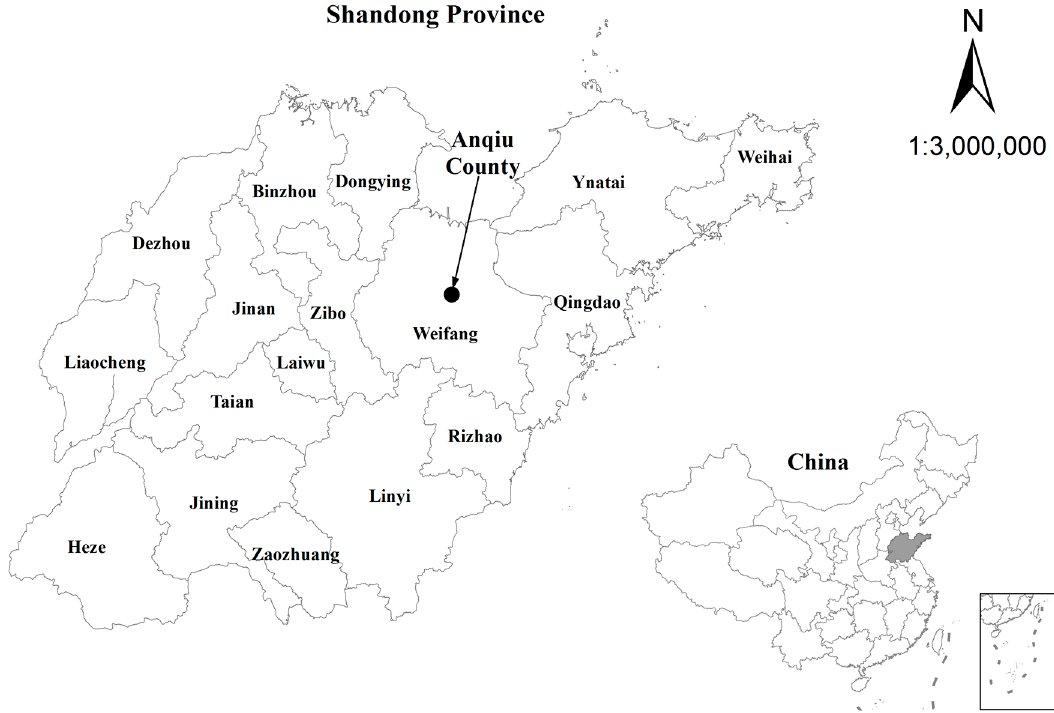
Figure 1. Location of the study area in China.